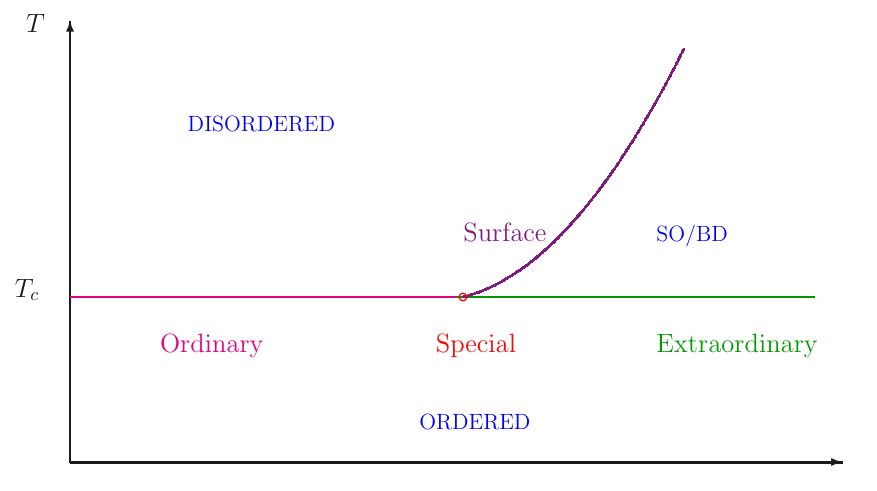
Figure 1 . Schematic phase diagram of a semi-infinite system at h 1 = h = 0